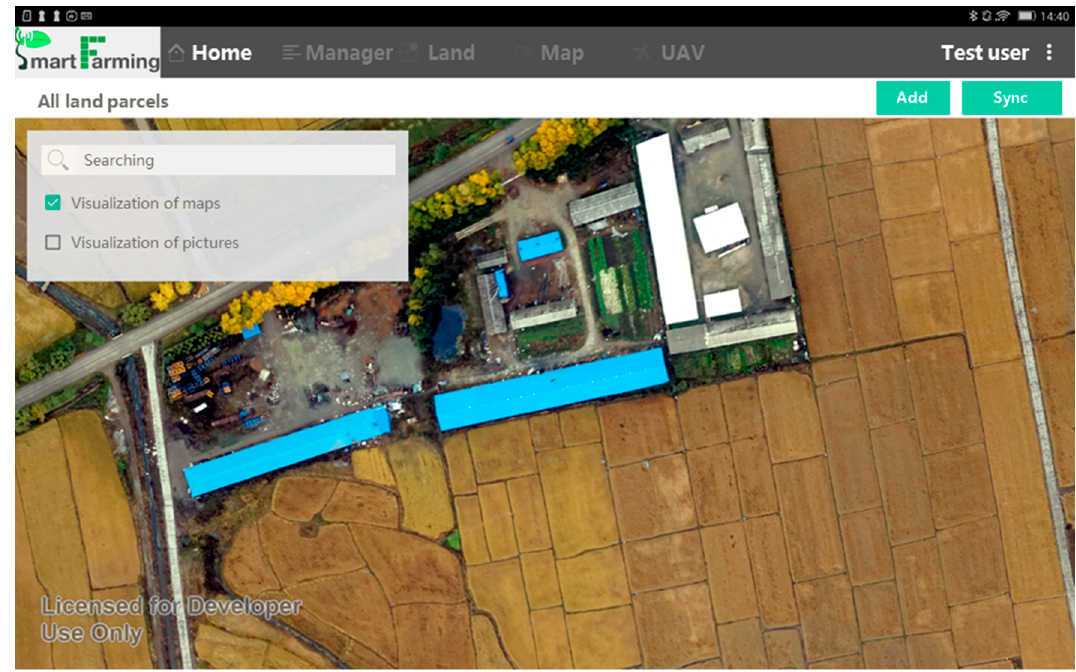
Figure 3. Visualization of a basemap in the eFarm app based on a timely acquired UAV image.